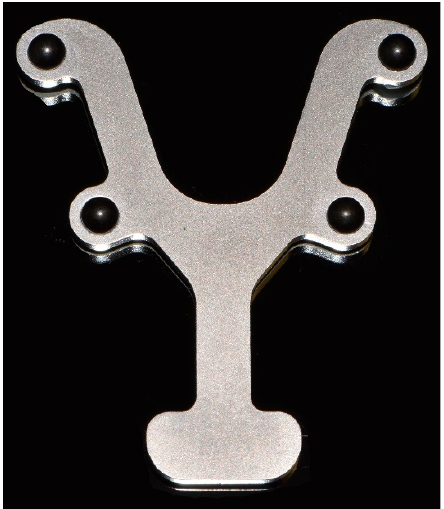
Figure 2 . Metal reference guide with the four steel spheres inserted. Figure 2. Metal reference guide with the four steel spheres inserted. Table 1. Intraoral scanners used in this